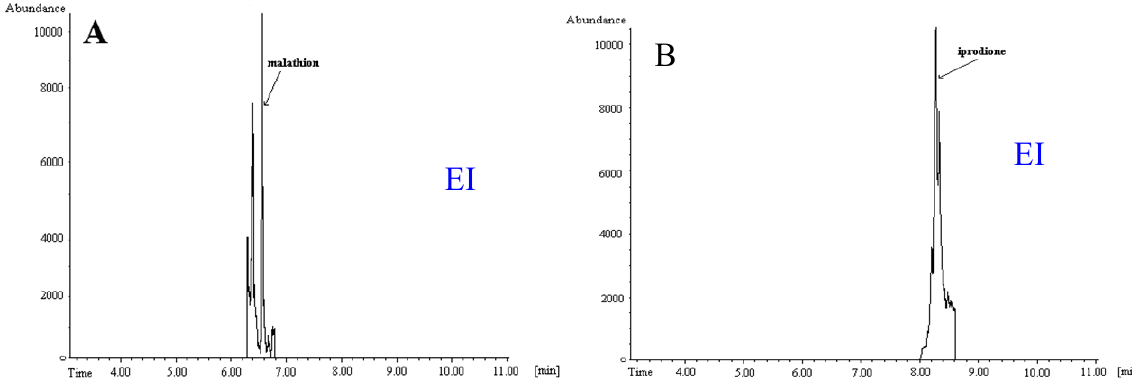
Figure 3. Chromatogram of target ions of EDPs analyzed by fast GC-MS in SIM in real samples; A — orange (malathion, determined concentration 50.1 µg/kg) in EI; B — strawberry (iprodione, determined concentration 40.9 µg/kg) in EI; C — orange in NCI; D — strawberry in NCI mode